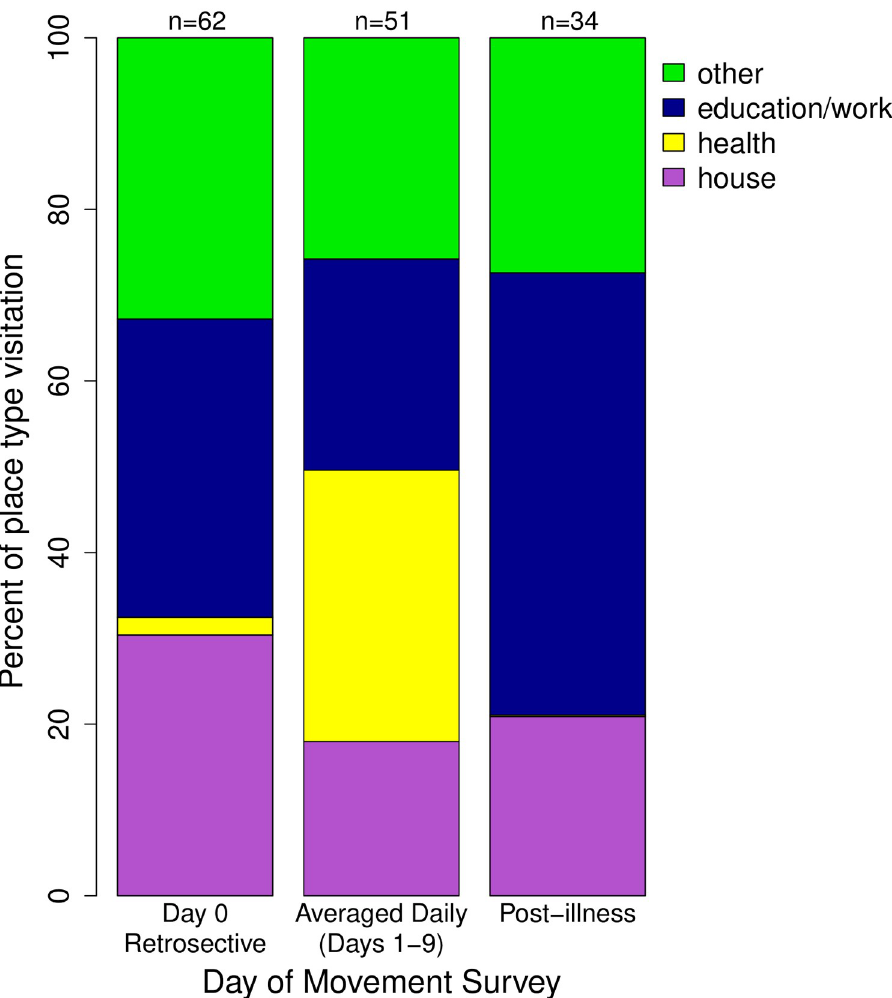
Fig 2. Place types visited throughout illness. Expressed as the percent of locations being visited of each location type. Other location type includes: markets, restaurants, ports, churches, cemeteries, recreational places, internet cafes, and all else. The number of participants who visited places is listed above each time